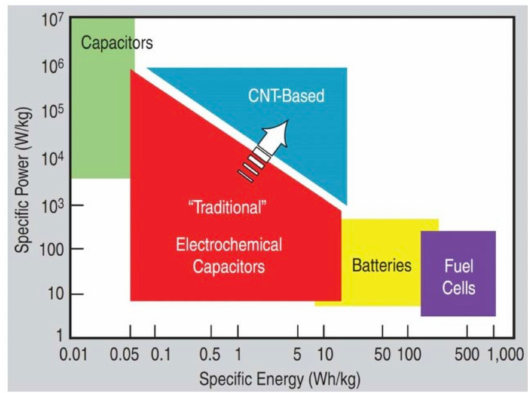
Figure 4. Ragone plot for the current generation of capacitors, supercapacitors, batteries, and fuel cells. Reprinted with permission from